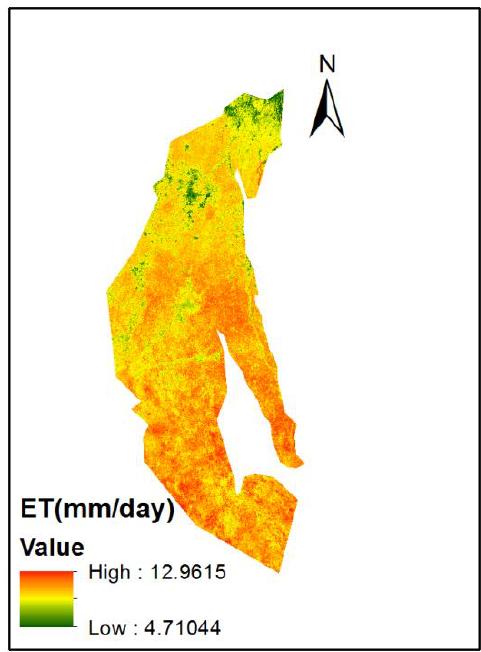
Figure 3. Actual Evapotanspiration map of UGC r = Aerodynamic resistance to heat flow from a hypothetical ah bare and dry surface, estimated at 110 sm −1 (Senay et al.,